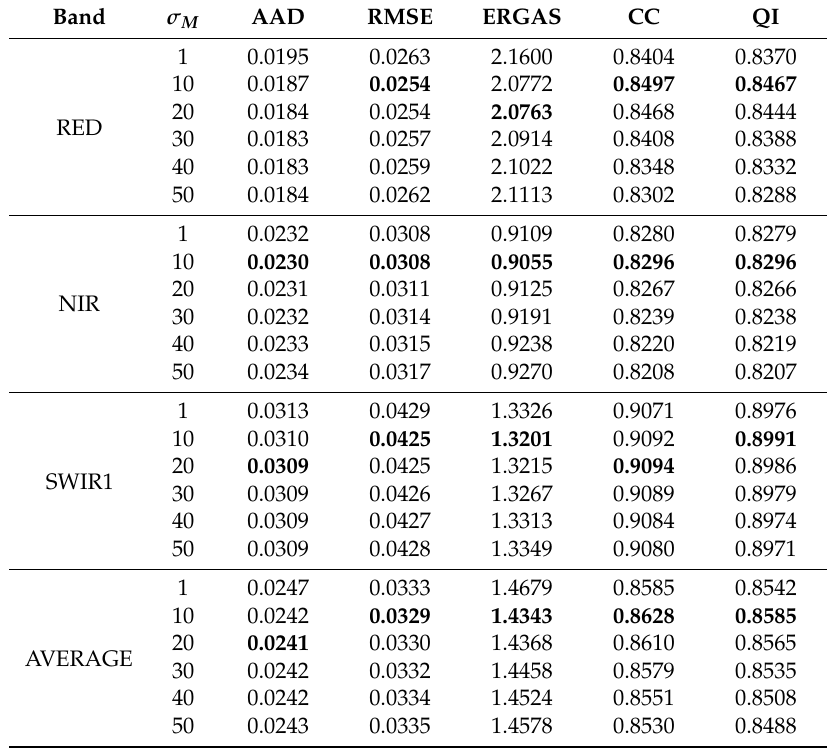
Table 5. Quality indices of predicted Landsat-like images by PSRFM with an empirically fixed priori pixel uncertainty of σ R = 40 for the input Landsat images and different priori pixel uncertainties σ M ranged from 1 to 50 for the input MODIS images for prediction dated 20 April